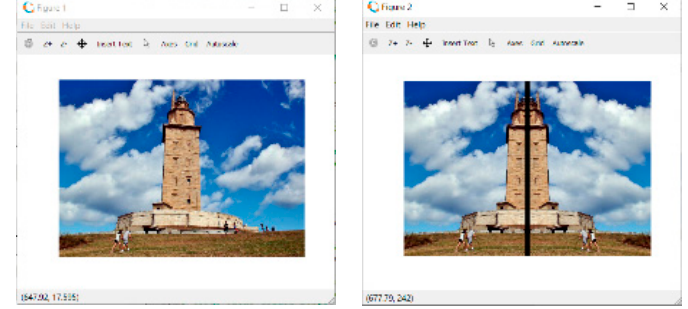
Figure 2. Example of two